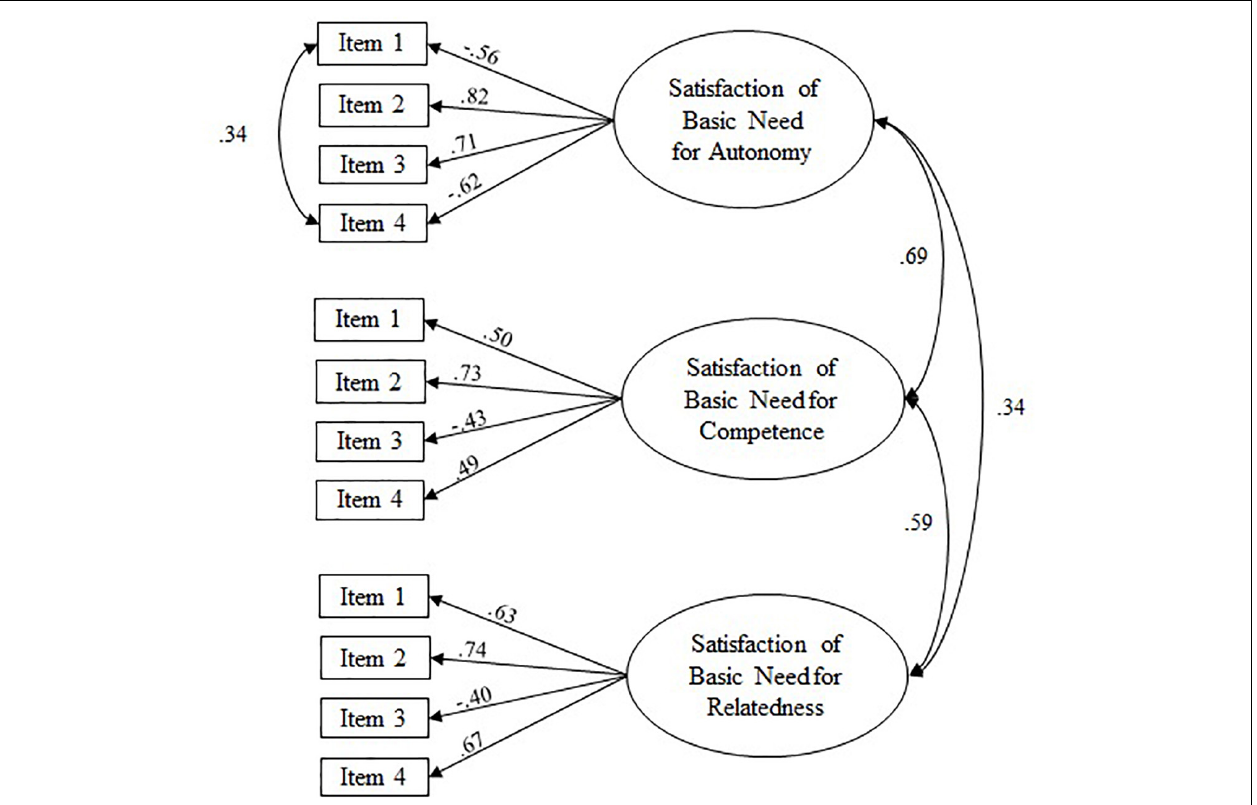
FIGURE 3 | Path coefficients from confirmatory factor analyses: three-factor model of satisfaction of the basic needs for autonomy and competence. Figure depicts standardized loadings; all loadings and correlations are significant ( p < 0.05); correlations between latent variables and indicators were specified as residual error correlations.